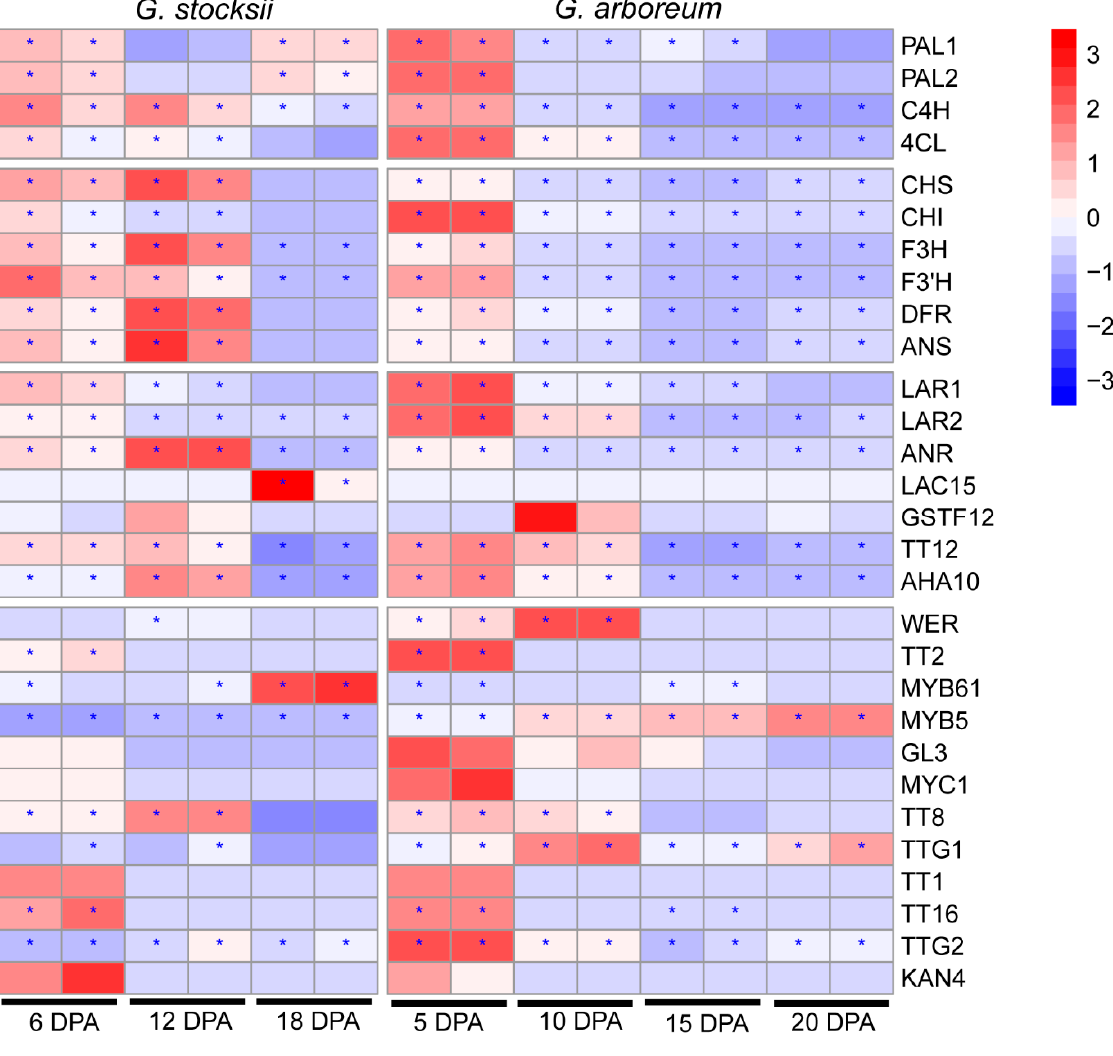
Figure 8. Expression of proanthocyanidin biosynthetic genes in developing fibers of Gossypium stocksii and Gossypium arboreum . The filled colors indicate the gene expression levels (from low: blue to high: red) (scaled by raw). The asterisks indicate the expression levels of FPKM > 10.